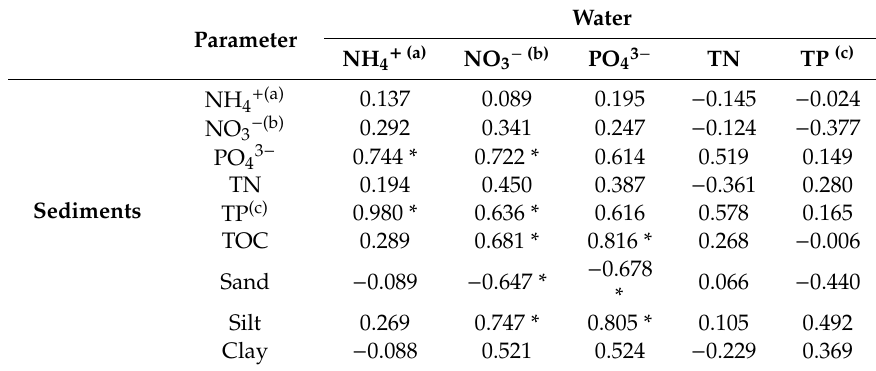
Table 6. Correlations between water and sediments (the significance limit of a correlation coe ffi cient based on Student’s t -test, r = 0.632, p = 0.05, n =